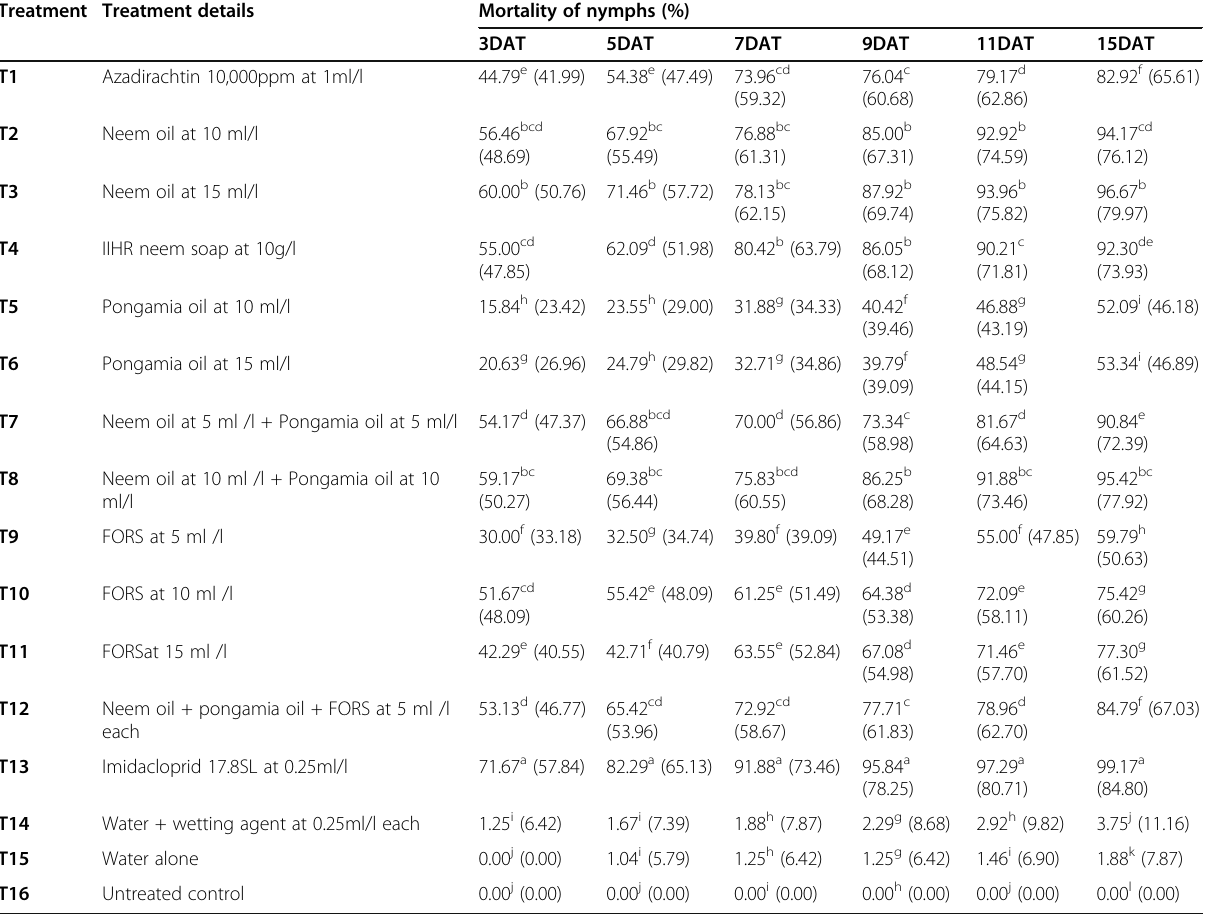
Table 3 Efficacy of botanical oils against Maconellicoccus hirsutus under laboratory condition Treatment Treatment details Mortality of nymphs